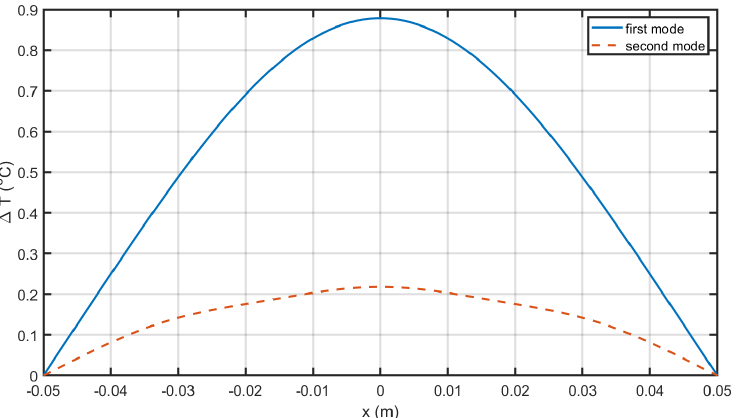
Figure 23. Power distribution inside BAW slab for first and second mode.